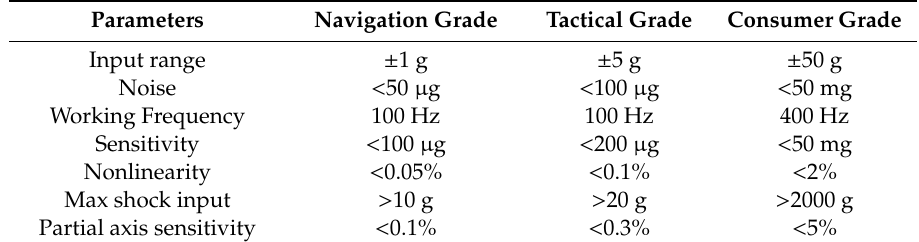
Table 1. Typical specifications of MEMS accelerometers on three performance levels, including tactical grade, navigation grade as well as auto control [5]. Parameters Navigation Grade Tactical